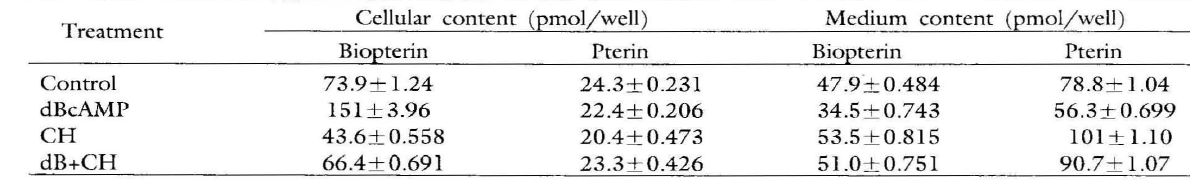
PC12 cells 111 12-well plates were cultured in the absence (control), and presence of 1 mM dBcAMP, 50 flg/